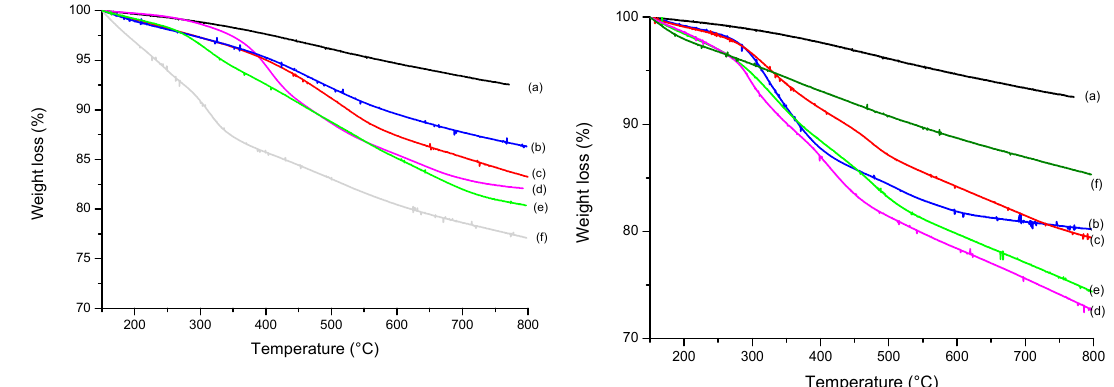
Figure 2. TGA profiles of organic inorganic silica derivatives. On the left : (a) silica, (b) Si-Gly, (c) Si-MonoAm, (d) Si-TriAm, (e) Si-DiAm, (f) Si-DETA (Table 1, entry 1–5). On the right : (a) silica, (b) Si-Gly-CD, (c) Si-MonoAm-CD, (d) Si-TriAm-CD, (e) Si-DiAm-CD, (f) Si-NHCD (Table 1, entry 6–10).